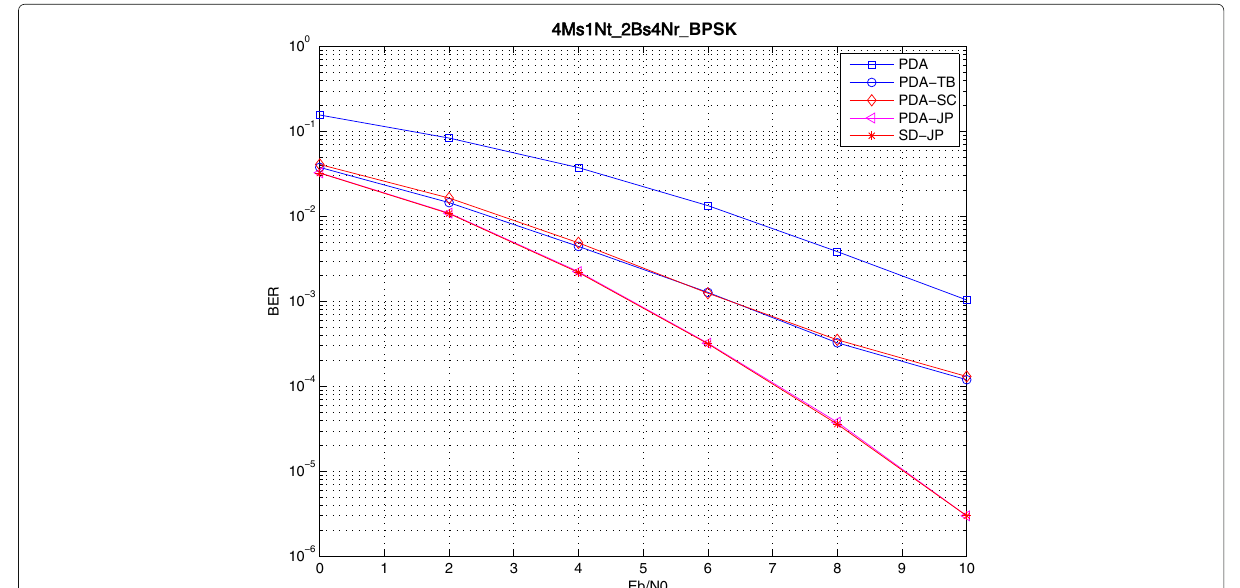
Fig. 1 BER performance with N m = 4 and N r =